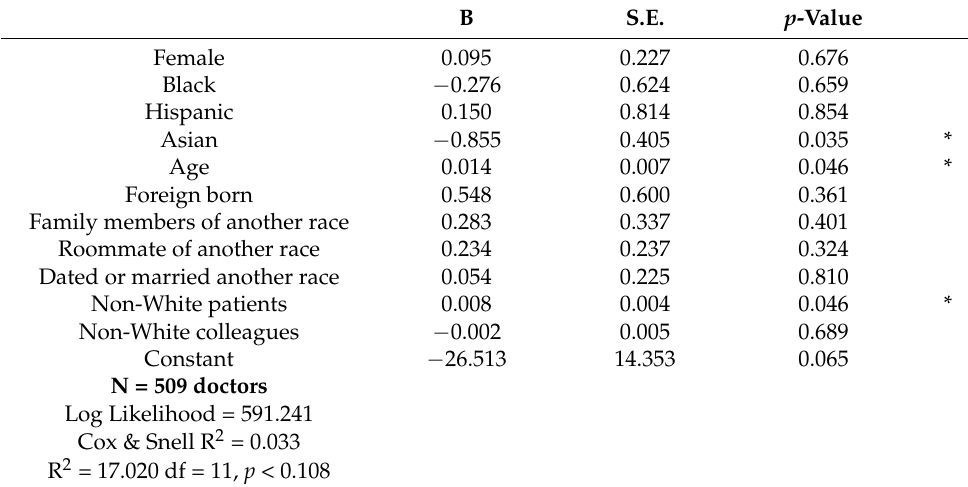
Table 4. Logistic regression of doctor characteristics on likelihood of considering race. B S.E. p